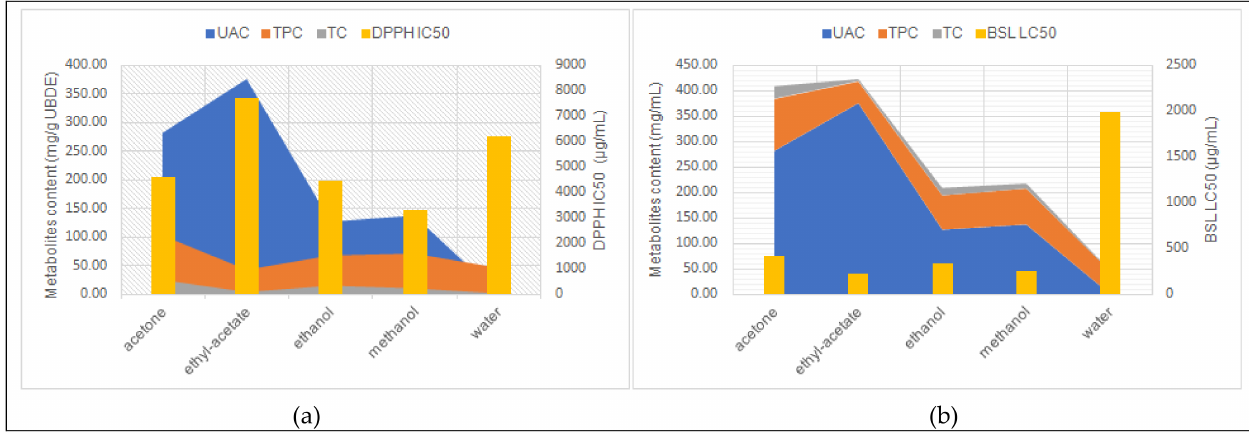
Figure 4. The correlation between the phytochemical profile of UBDE and antioxidant activity ( a ) and cytotoxic effect ( b ), expressed by DPPH IC 50 and BSL LC 50 ,